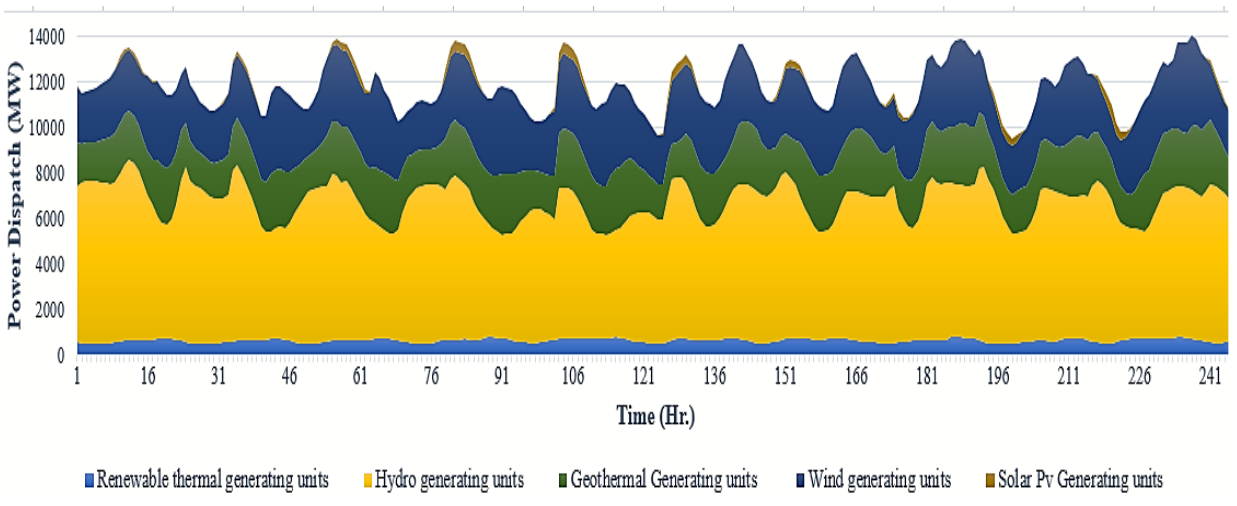
Figure 11. Ethiopian Renewable Energy Systems dispatch